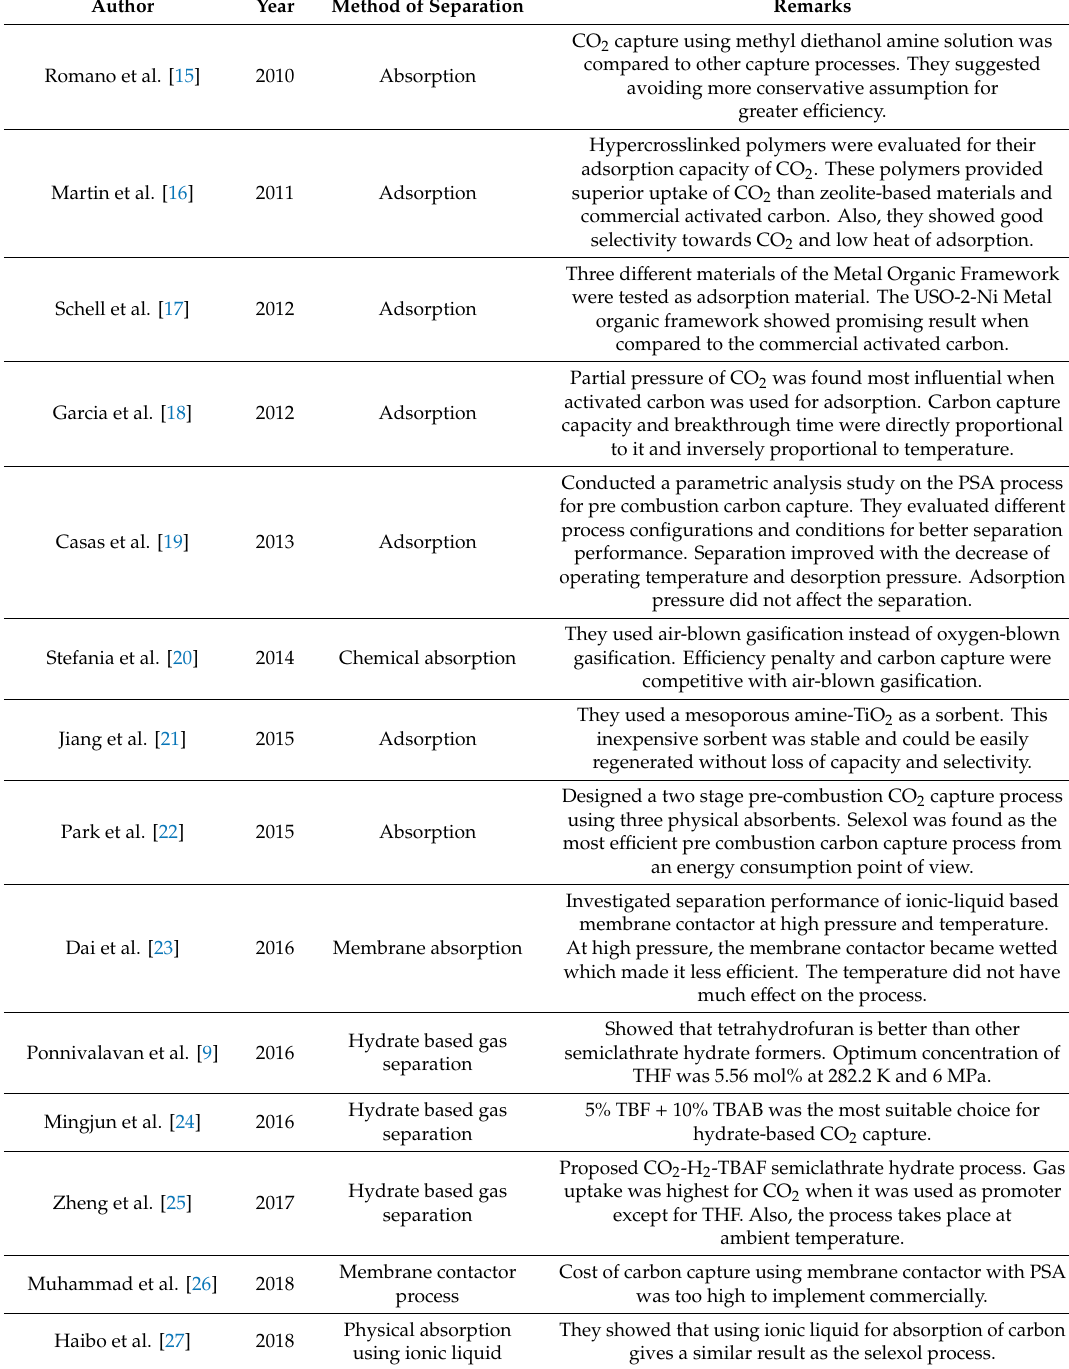
Table 1. Summary of some important studies on precombustion carbon